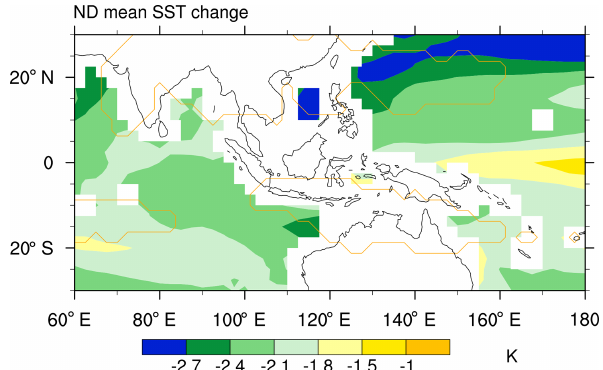
Figure 10. ND mean SST difference between LGME and piCon- trol. The red lines enclose the monsoon domains. Only those areas where the signal-to-noise ratio exceeds 1 are